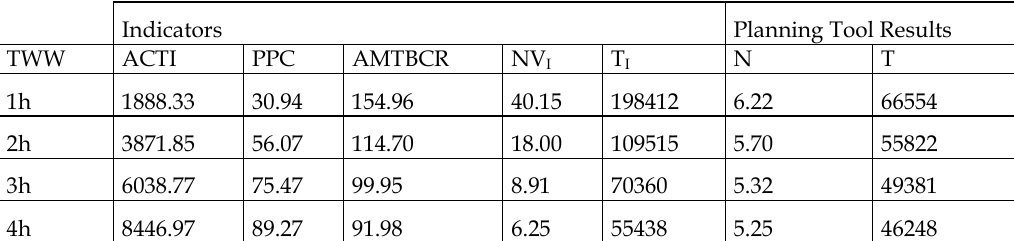
Table 1. Average values of the indicators for Set